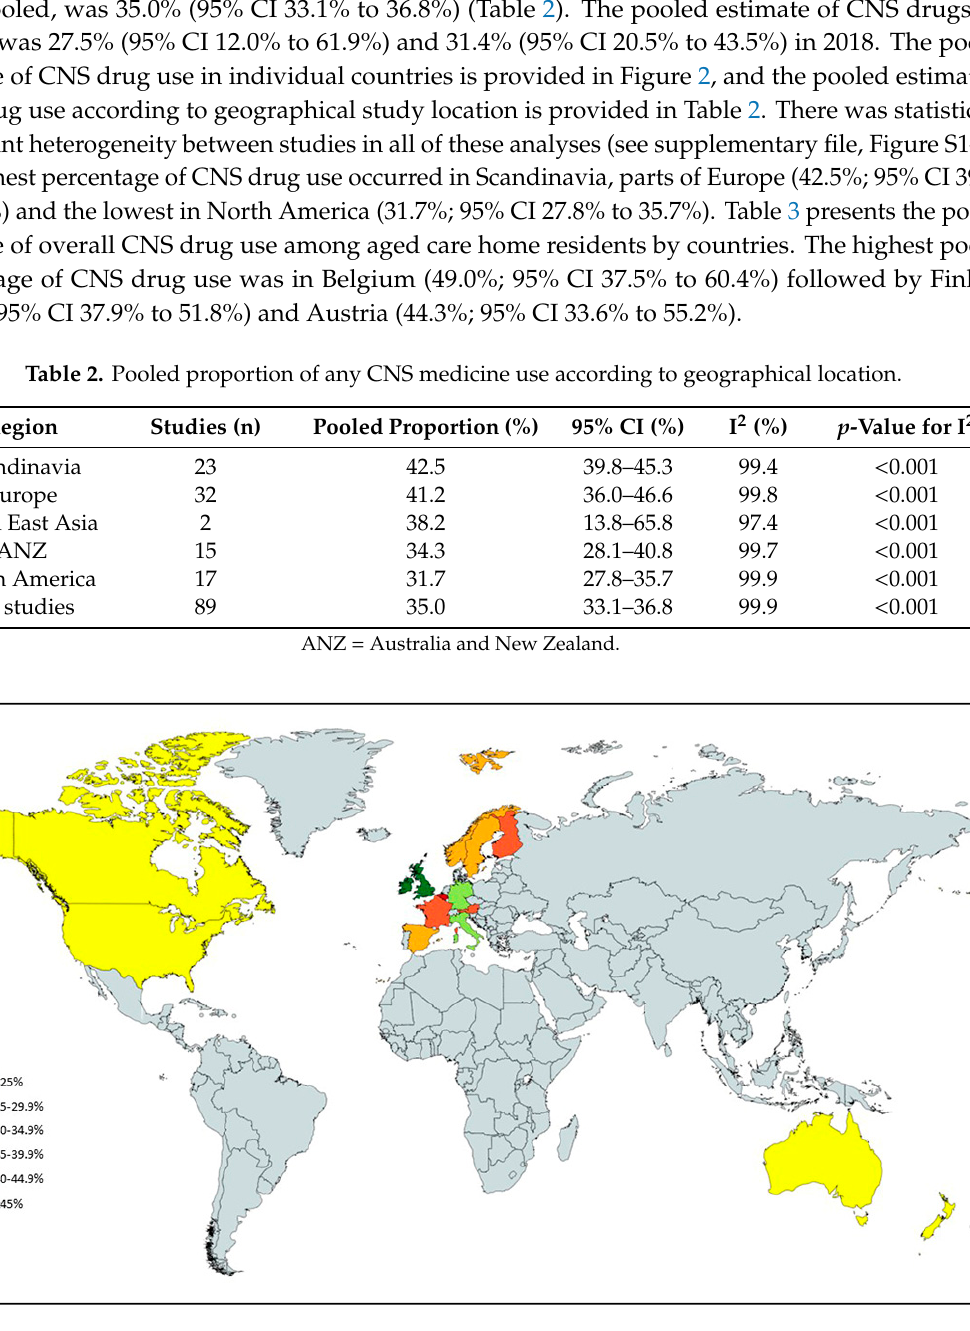
Figure 2. Overall CNS drugs use among care homes residents (countries with at least 2 studies). Table 2. Overall CNS drugs use among care homes residents by countries.